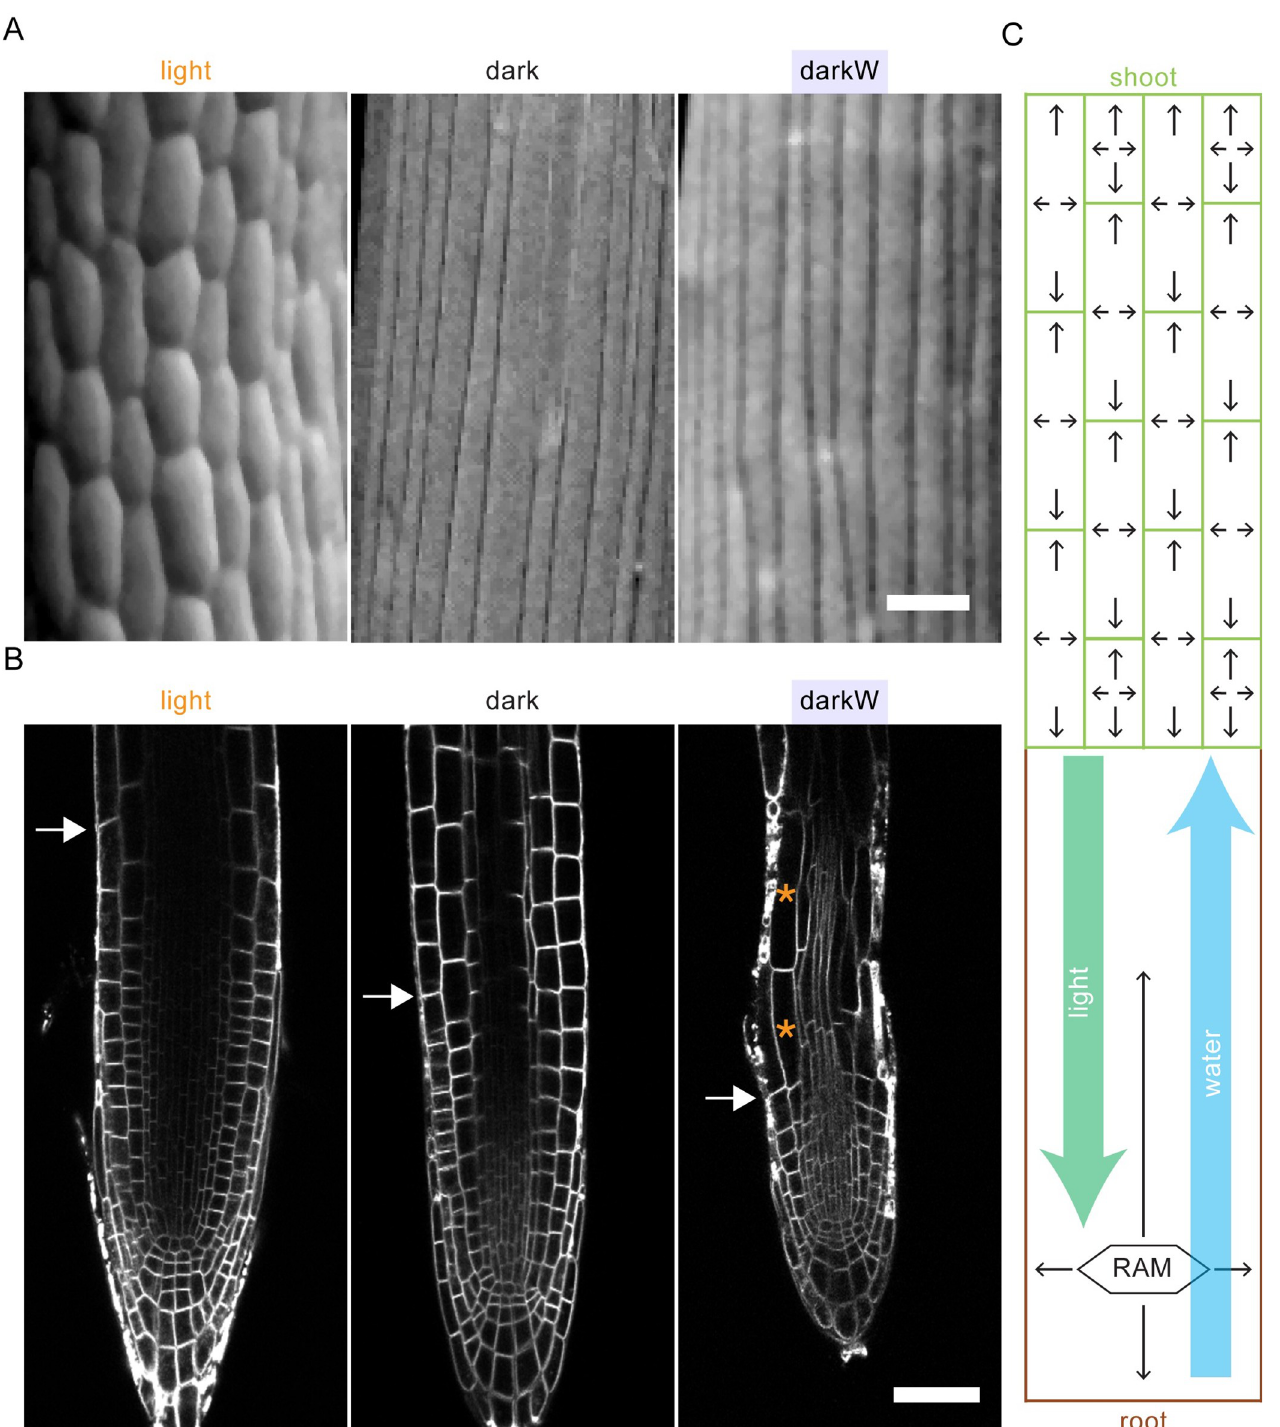
Fig 7. Growth regulation and information flow in response to the availability of water and light. (A) Scanning electron micrographs of wild-type (Col-0) hypocotyls under different environmental conditions. (B) Confocal micrographs of root tips under different environmental conditions; white arrows mark the junction between the meristematic and elongation zones (depicted as mean meristem size in Fig 6A ) as assessed by mixed Gaussian model analysis ([43]: S14 Fig ) and orange asterisks mark the highly elongated cells at the very beginning of the elongation zone under darkW. Wild type (Col-0) for light and dark; P BRI1 ::BRI1-GFP for darkW; FM4-64 signal in all cases. Scalebar: 50 μ m. (C) Information-flow diagram as a translation of our empirical findings. The green rectangles in the upper part of the diagram represent hypocotyl cells, and the arrows within each cell depict growth as a decentralized cellular response. The